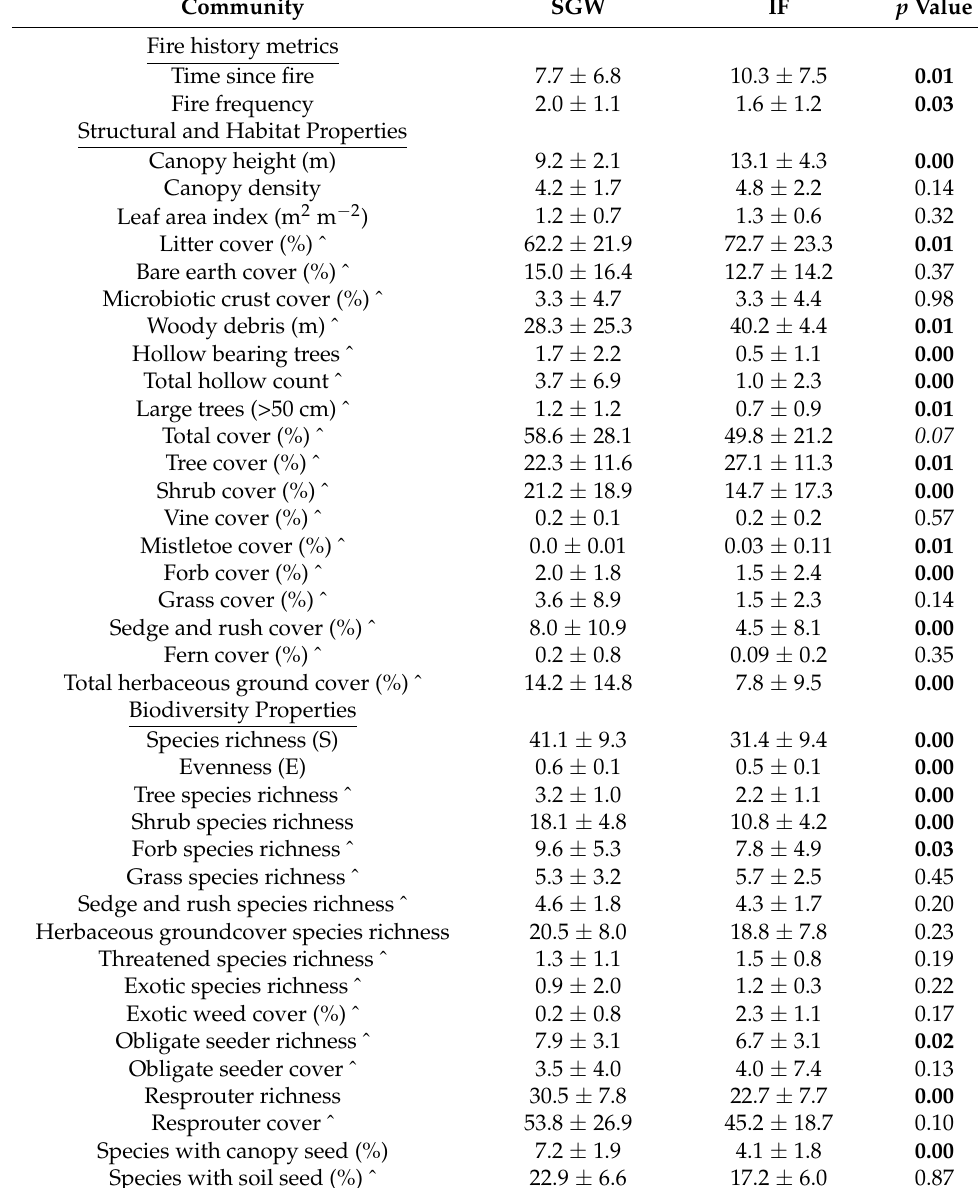
Table 1. Fire history of the last 25 years, vegetation structure, habitat values and biodiversity metrics of Scribbly Gum Woodland (SGW) and Ironbark Forest (IF) near Sydney, Australia. Shown are mean ± standard deviation (SD) across plots within each Threatened Ecological Community. Exotic species are included in all richness and cover values and evaluated separately below. Significant difference ( p value < 0.05) between the two communities indicated in bold and marginal significance indicated in italics ; T-tests were used where data met normality requirements and Mann–Whitney Rank Sum tests were used if not (indicated by